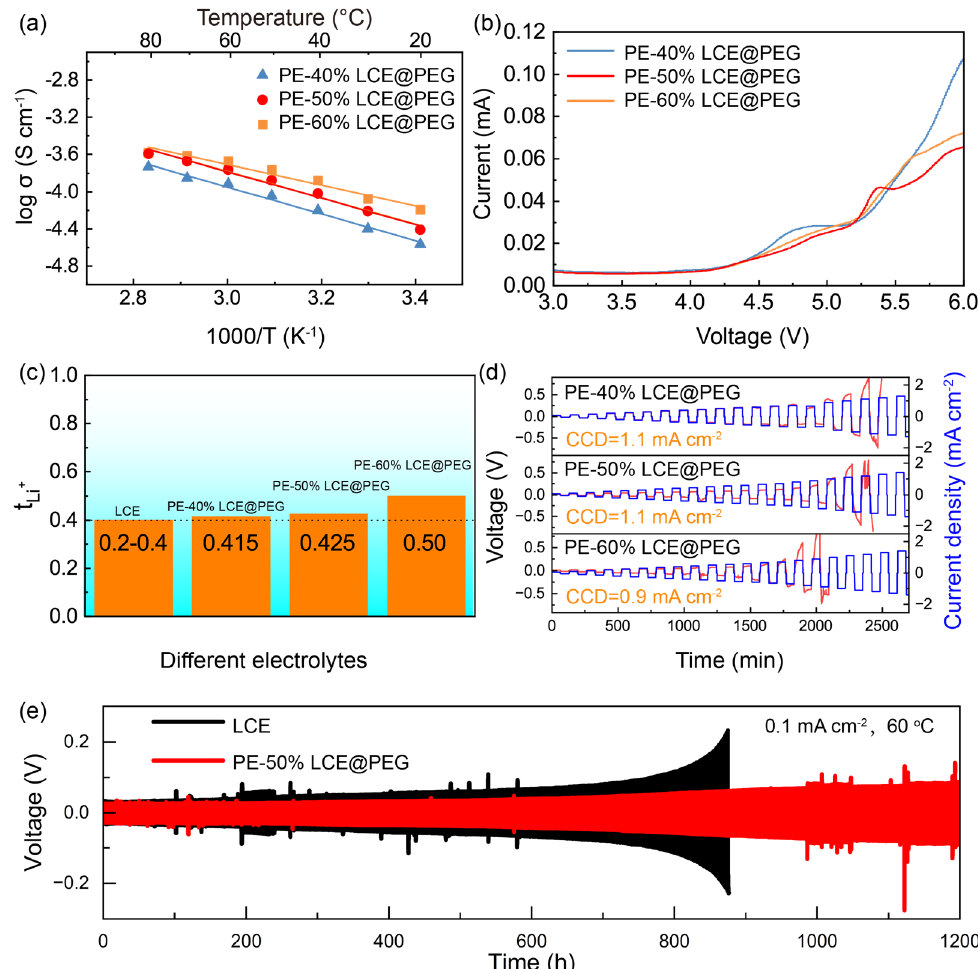
Figure 3. ( a ) Arrhenius plots of PE − x %LCE@PEG ( x = 40, 50, and 60) gel polymer electrolytes. ( b ) Linear sweep voltammetry of PE − x %LCE@PEG ( x = 40, 50, and 60) gel polymer electrolytes. ( c ) Li + transference number comparison of LCE and PE − x %LCE@PEG ( x = 40, 50, and 60) gel polymer elec- trolytes. ( d ) Critical current density test of Li/PE − x %LCE@PEG ( x = 40, 50, and 60)/Li cells at 60 °C. ( e ) Long − term cyclic performances of Li//Li symmetrical cells using the LCE and PE − 50%LCE@PEG gel polymer electrolytes at 0.1 mA cm − 2 and 0.1 mAh cm − 2 under 60 °C.